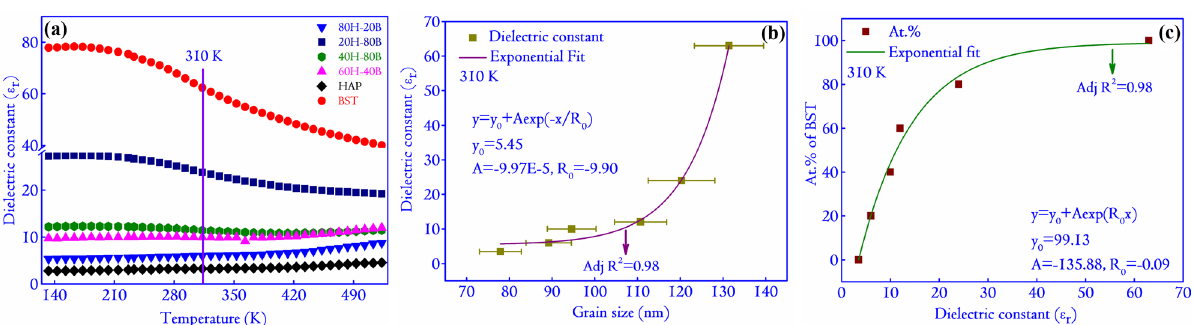
Figure 7. ( a ) The variation in the dielectric properties of the composites with respect to temperature at 1 MHz. The significant spike in the values is due to a probable phase transition of BST, and ( b ) shows the dependence of the 𝜖 r (at 310 K) on the grain size of the composites. The relationship is found to be exponential with the adjusted R square value of 0.98. Similarly, ( c ), the variation of 𝜖 r with respect to the at.% of BST in the composites is considered. The variation is again exponential, with the R square value of the fit at